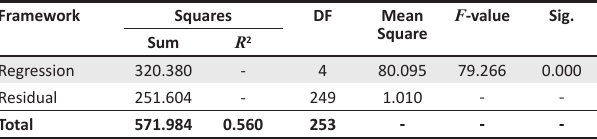
TABLE 3a: Influence of the independent variables on customer relationship management. Framework Squares